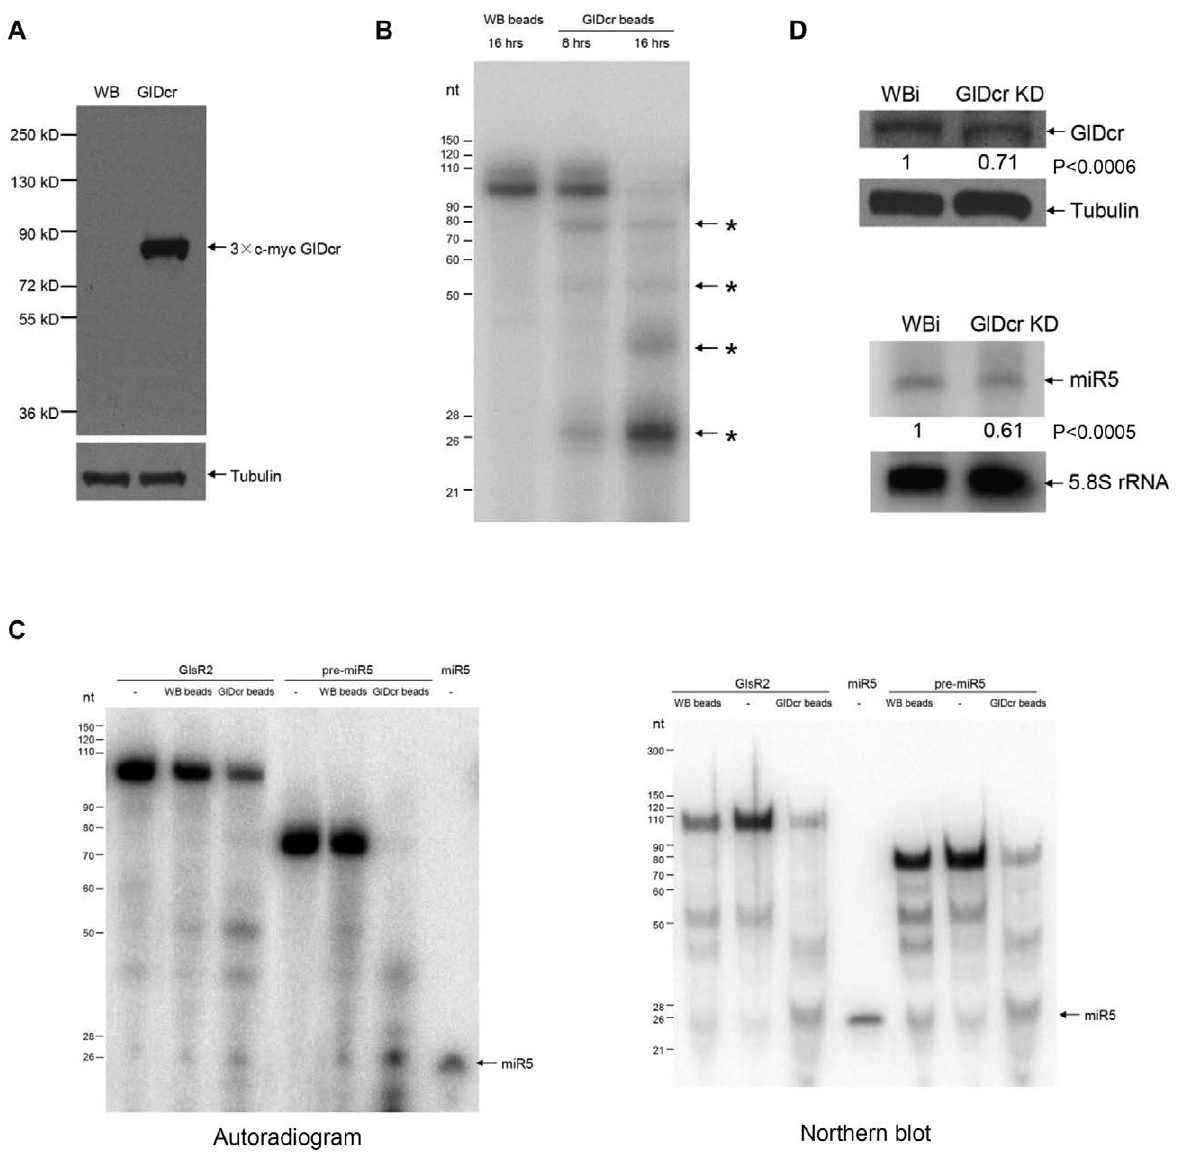
Figure 4. GlDcr is required for processing GlsR2 to generate miR5. ( A ) Western blot of 3 6 c-myc GlDcr that was immunoprecipitated using the anti-c-myc antibody. GlDcr: 3 6 c-myc GlDcr over-expressing cells. WB: un-transfected cells. Tubulin: loading control. ( B ) In vitro dicing of a 106 bp 32 P-dsRNA. The labeled dsRNA was incubated with the immunoprecipitate from the untransfected cells (WB beads, left lane) and the transfected cells (GlDcr beads, center and right lanes) and incubated at 37 u C for 8 or 16 hrs. The smaller RNA fragments were shown with asterisks. ( C ) In vitro dicing of GlsR2 and the 75 nt pre-miR5. Left panel: The purified GlDcr beads were incubated with the radiolabeled substrates at 37 u C for 16 hours and analyzed with RNA PAGE and autoradiography. In vitro transcribed GlsR2 and pre-miR5 incubated with water (-) and WB beads were included as controls. Right panel: Unlabeled GlsR2 and pre-miR5 were digested by the GlDcr beads. After RNA PAGE, the gel was blotted and analyzed by a Northern using end-labeled anti-miR5 as probe. WB beads and water (-) were also included as the controls. ( D ) GlDcr is essential for biogenesis of miR5. Upper panel: Western blot using anti-GlDcr polyclonal antibody showed that GlDcr was knocked down by 29% in GlDcr knockdown (GlDcr KD) cells. WBi was the control cells and Tubulin was the loading control. Lower panel: Northern blot shows that the endogenous miR5 level was decreased by 39% in GlDcr KD cells. The 5.8S rRNA was used as a loading control. The results were from three independent experiments. The p-values indicated were calculated by two-tailed Student’s t